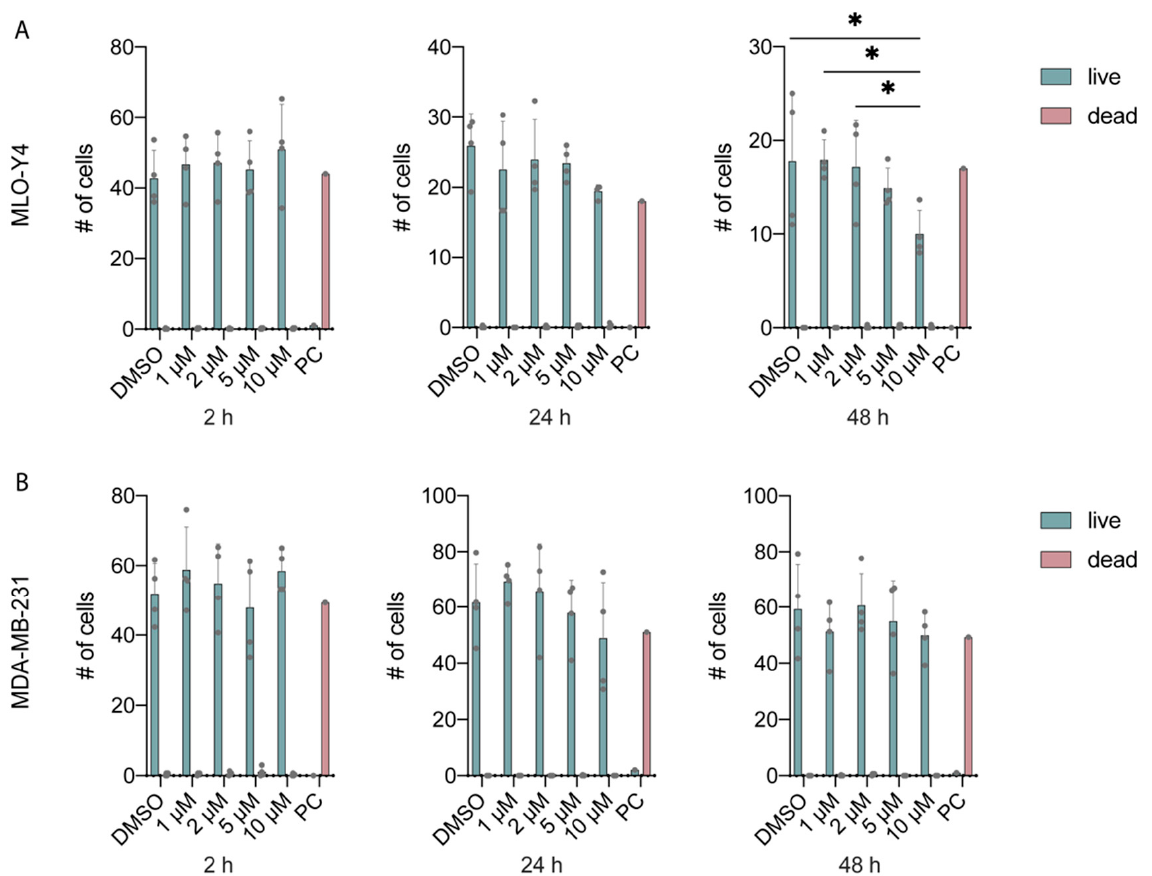
Figure 2. Live-dead measurements of MLO-Y4 and MDA-MB-231 under dose-dependent Yoda1 treatments for 2, 24, and 48 h. ( A ) Live-dead measurements of MLO-Y4, ( B ) live-dead measurements of MDA-MB-231 after subjected to DMSO or 1, 2, 5, 10 µ M Yoda1 for 2, 24, and 48 h ( n = 4 for DMSO and Yoda1 treatments, n = 1 for PC). PC: positive control. * p < 0.05.